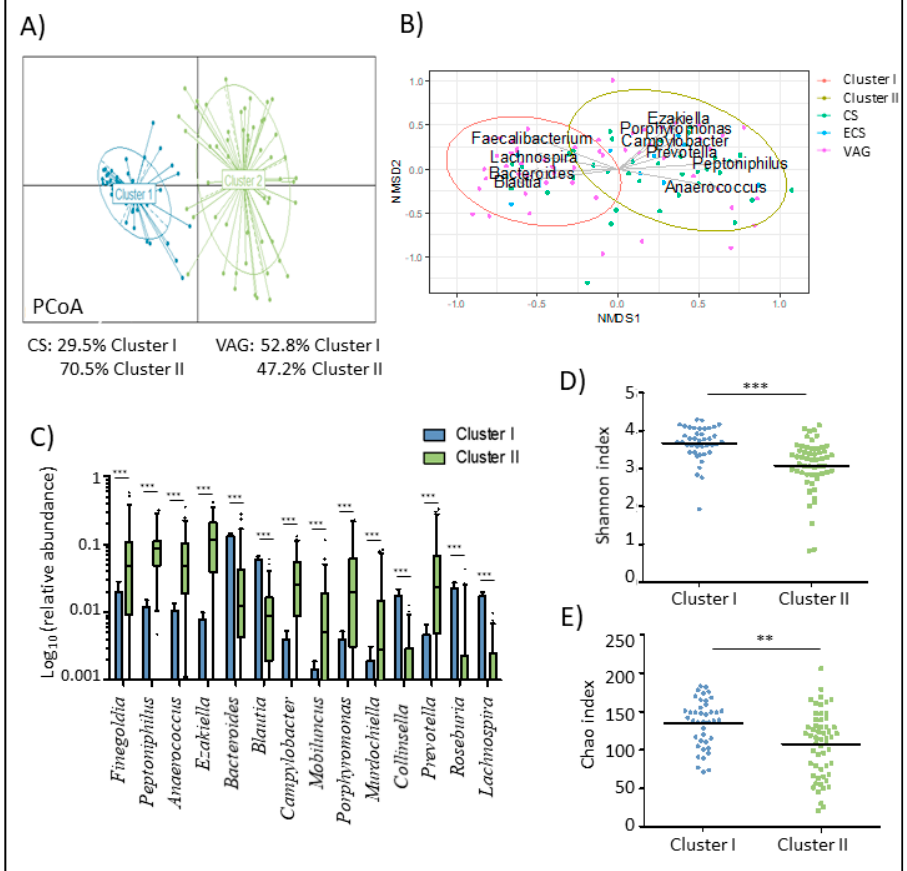
Figure 1. Maternal microbiota was clustered in two groups based in their composition and diversity at delivery. ( A ) Principal coordinate analysis (PCA) of maternal microbiota at delivery according to the cluster at the genus level. ( B ) Non-metric multidimensional scaling (NMDS) of the maternal microbiota at delivery time at amplicon sequence variant (ASV). Arrows show the genus loadings for each cluster. the color of the points expresses the delivery mode group of the mother. ( C ) Boxplot of the main genera that marked the difference of the maternal microbiota composition between both clusters. Data was transformed by log10 of the relative abundance of each genus for plotting. Whiskers represent the 5-95 percentile interval. ( D , E ) Differences in the diversity ( D ) and richness ( E ) of maternal microbiota based on the Shannon index according to the cluster. Line represents the median of each group. * p < 0.05. ** p < 0.01. *** p < 0.001. A higher relative abundance of Blautia ( p < 0.001), Rombustia ( p < 0.001), Roseburia ( p < 0.001), Lachnospira ( p < 0.001), and several groups from the Ruminococcaceae family was found in cluster I compared to cluster II. However, cluster II mothers had a higher relative abundance of Prevotella ( p <